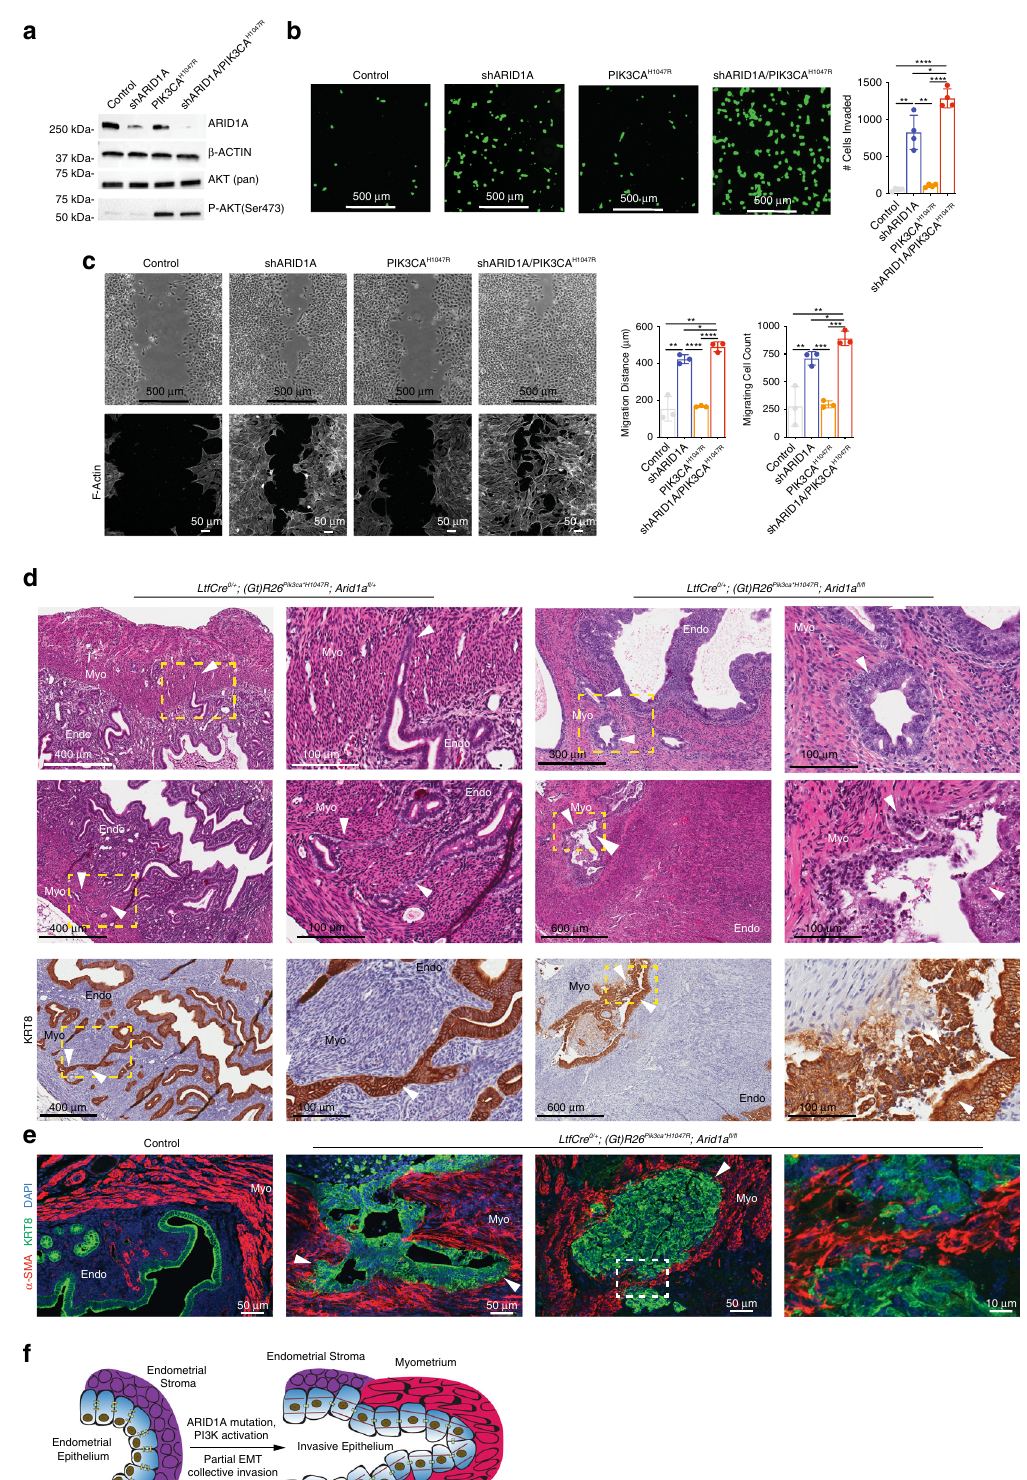
whereas loss of ARID1A immunoreactivity correlates with malignant transformation in endometrial cancer 15 . A recent study identi fi ed PIK3CA as being commonly mutated in endometrial glands, often without transformation, suggesting PIK3CA muta- tion as an early event, with ARID1A mutation coming later in the progression of endometriosis 17 . ARID1A mutations